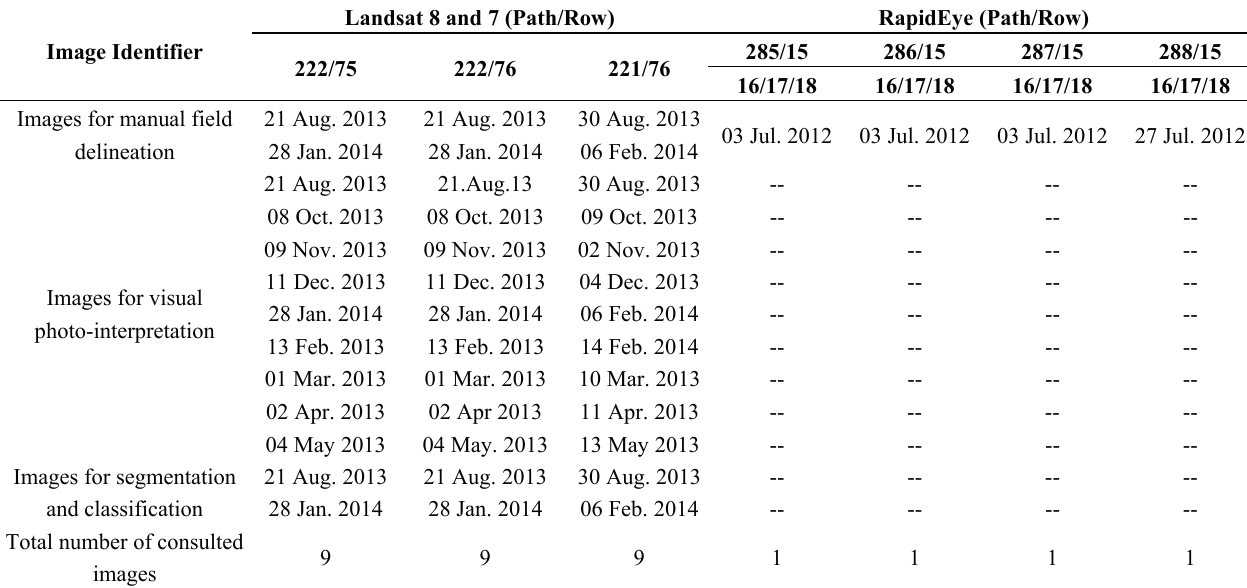
Table 2. Images (Landsat and RapidEye) used for the study.